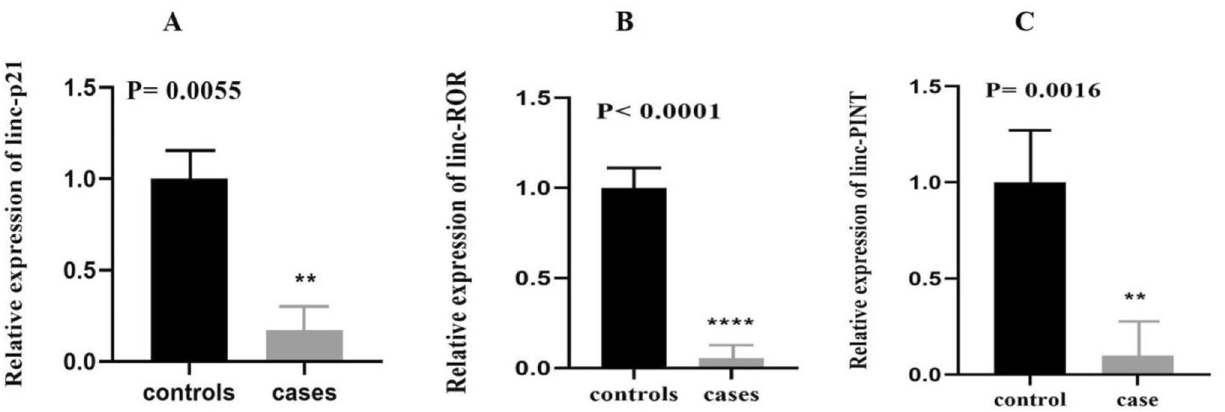
Figure 1. Expression analysis of lncRNAs in the PBMCs. The relative expression (Fold change) of linc-p21 ( A ), lncRNA-ROR (B), and linc-PINT ( C ). Expression of lncRNAs was significantly down-regulated in BD patients compared to controls. Gene expression levels of each sample were normalized relative to GAPDH expression. The relative expression of transcripts was obtained using the formula 2 -ΔΔCt and